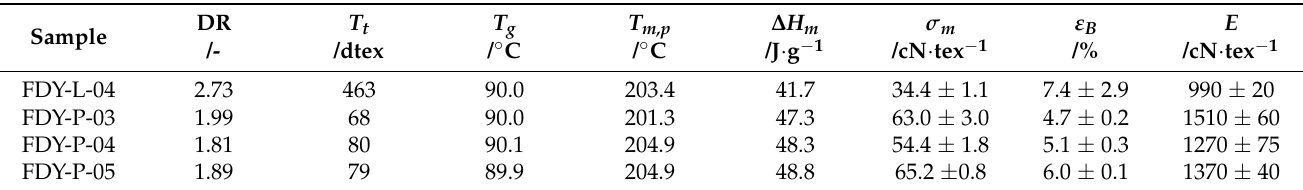
Table 4. Summary of DSC and tensile characteristics of FDYs (DR: draw ratio; T t : titer; σ m : tensile strength; ε : elongation at break; E : Young’s modulus); the nomenclature of samples is declared in section S1, and the tensile test output data and curves are shown in Figures S4.1 and S4.2.